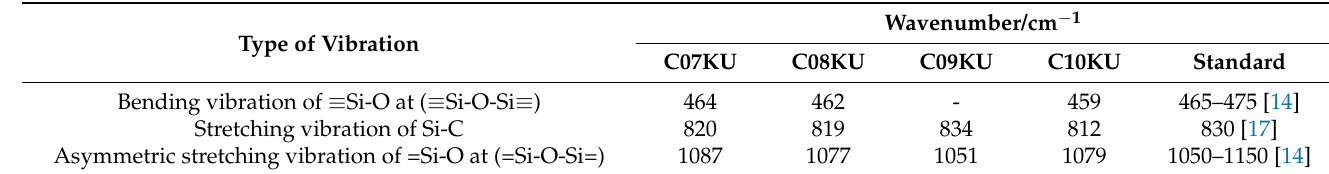
Table 4. Comparison of the absorption of the reduction products after calcination in an atmosphere of air at a temperature of 700 ◦ C.